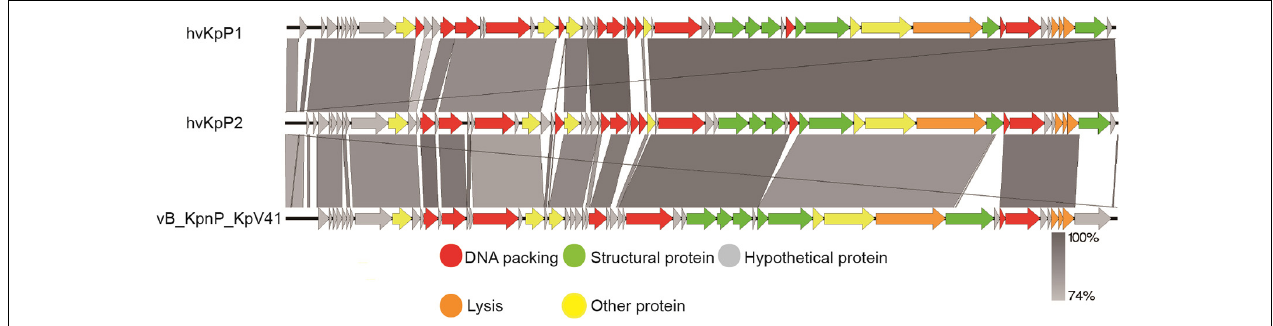
mutants were 5 × 10 − 5 ± 1 × 10 − 5 . We are interested in whether these phage-resistant K. pneumoniae would have an